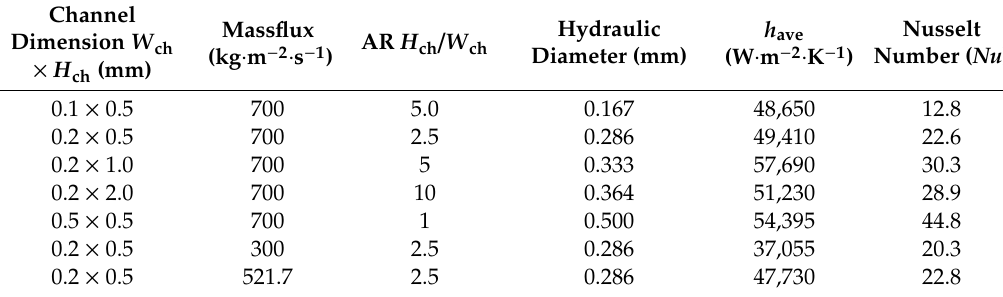
Table 4. Comparison of Nusselt number for di ff erent